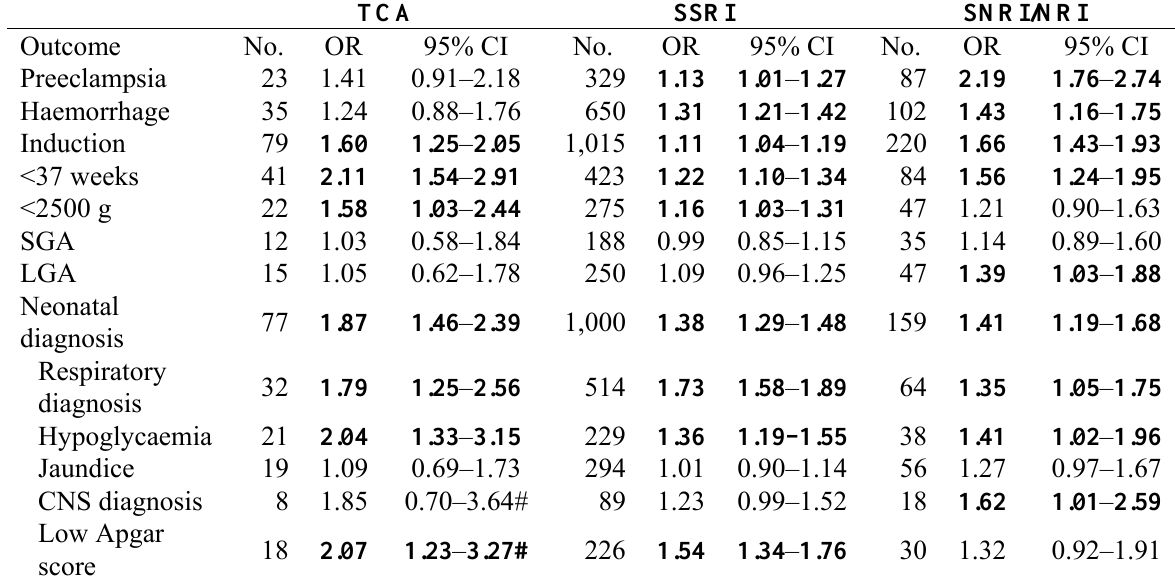
Table 37. Outcomes for three different groups of antidepressants: TCA, SSRI and SNRI/NRI. Bold text marks statistical